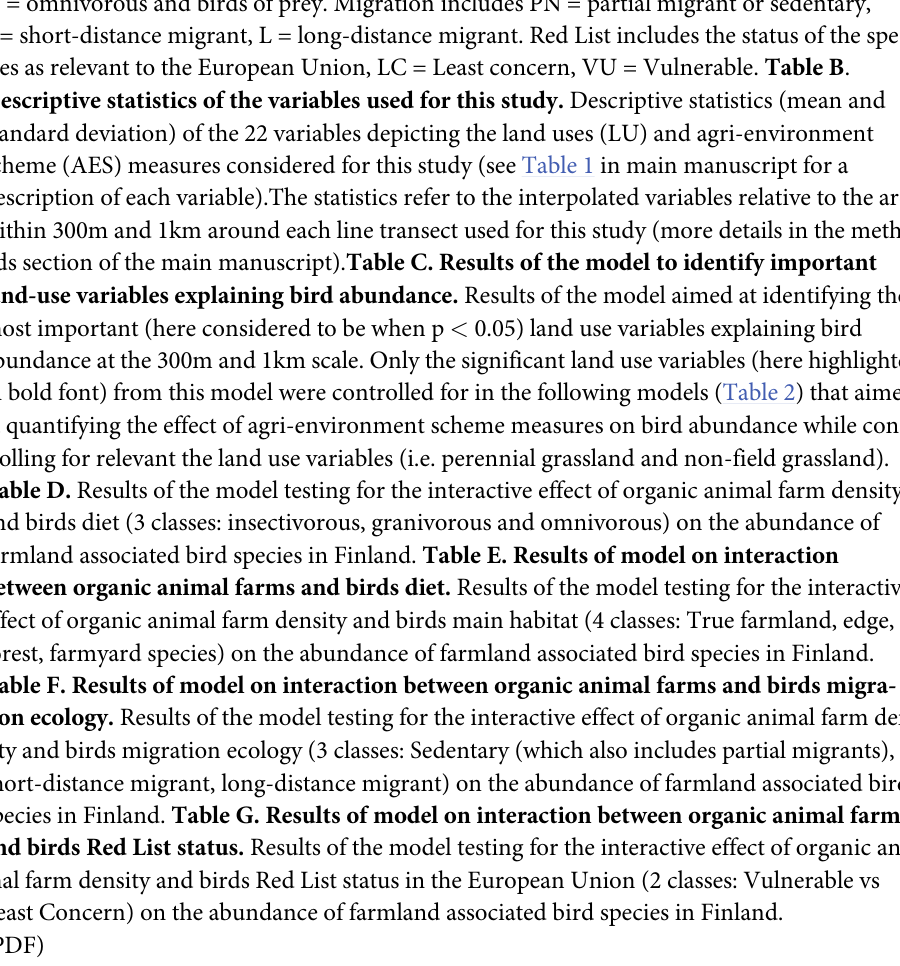
Table D. Results of the model testing for the interactive effect of organic animal farm density and birds diet (3 classes: insectivorous, granivorous and omnivorous) on the abundance of farmland associated bird species in Finland. Table E. Results of model on interaction between organic animal farms and birds diet. Results of the model testing for the interactive effect of organic animal farm density and birds main habitat (4 classes: True farmland, edge, forest, farmyard species) on the abundance of farmland associated bird species in Finland. Table F. Results of model on interaction between organic animal farms and birds migra- tion ecology. Results of the model testing for the interactive effect of organic animal farm den- sity and birds migration ecology (3 classes: Sedentary (which also includes partial migrants), short-distance migrant, long-distance migrant) on the abundance of farmland associated bird species in Finland. Table G. Results of model on interaction between organic animal farms and birds Red List status. Results of the model testing for the interactive effect of organic ani- mal farm density and birds Red List status in the European Union (2 classes: Vulnerable vs Least Concern) on the abundance of farmland associated bird species in